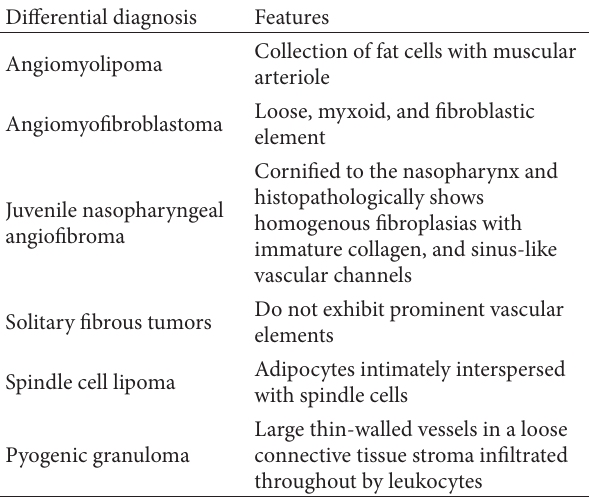
Table 1: Differential diagnosis of angiofibroma and specific features